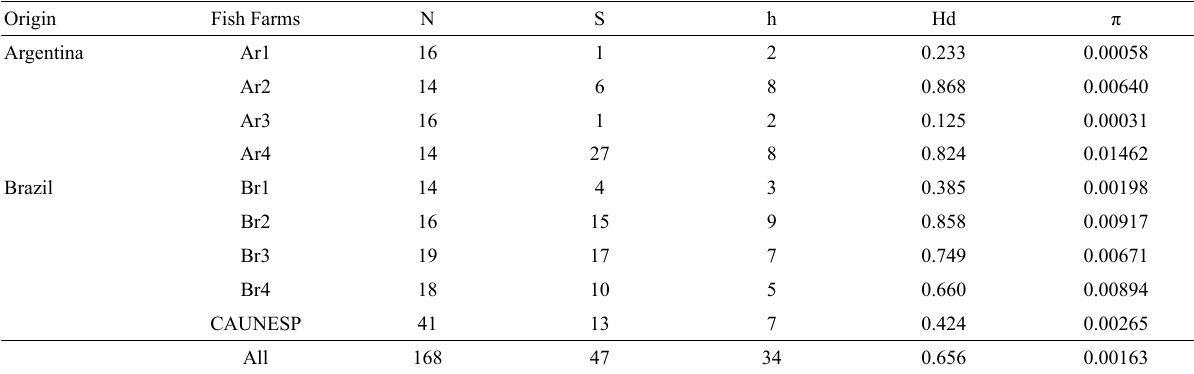
Table 1 - Genetic parameters of mtDNA diversity in farmed individuals of P. mesopotamicus .